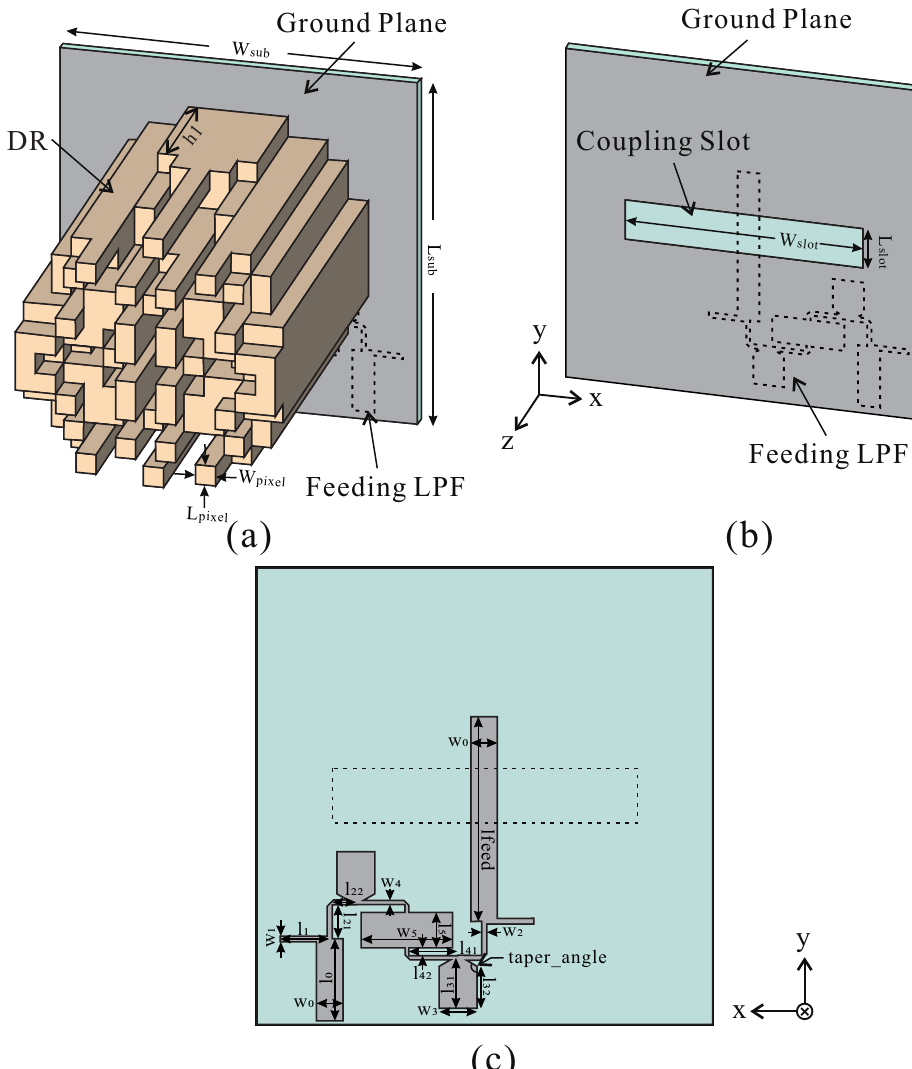
Figure 1. The configuration of the proposed antenna: ( a ) overall view, ( b ) substrate view, and ( c ) back side-cut view of the substrate (the x – y plane). DR = dielectric resonator. LPF = low-pass filter. The DR in Figure 1a comprised a fixed cylinder shape divided by a 13 × 13 grid. There are 137 bars in the grid, each with a size of L pixel × W pixel = 3.3 × 3.3 mm 2 . The height of the bar was optimized with the GLPSO algorithm to induce a high-order mode with wide HPBW characteristics, and the length of each bar has a value in the range of 5–60 mm. To shorten the optimization time, the grid was divided into quadrants that were symmetri- cal to the original (first) quadrant. The chromosomes correspond to the height of the rod. The GLPSO included 1000 iterations and 40 populations and was set at a mutation ratio of 0.01. The cost function was set to form a wide beamwidth with a far-field radiation pattern with a constant gain at θ = − 90 ◦ ∼ +90 ◦ . Taconic RF-35 ( (cid:101) r = 3.5), with a thickness of 1.52 mm and a size of W sub × L sub = 60 × 60 mm 2 , was used as a substrate. A slot etched on the ground surface ( W slot × l slot = 40 × 7 mm 2 ) enabled the coupling of the feeding line and the DR (Table